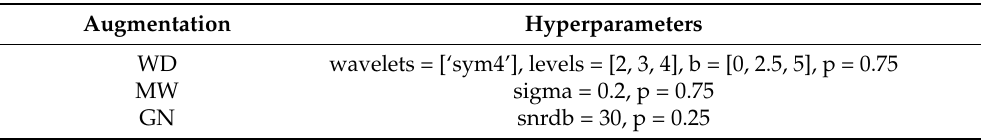
Table 2. Hyperparameter values for each of the augmentation methods, Wavelet Decomposition (WD), Magnitude Warping (MW), and Gaussian Noise (GN)